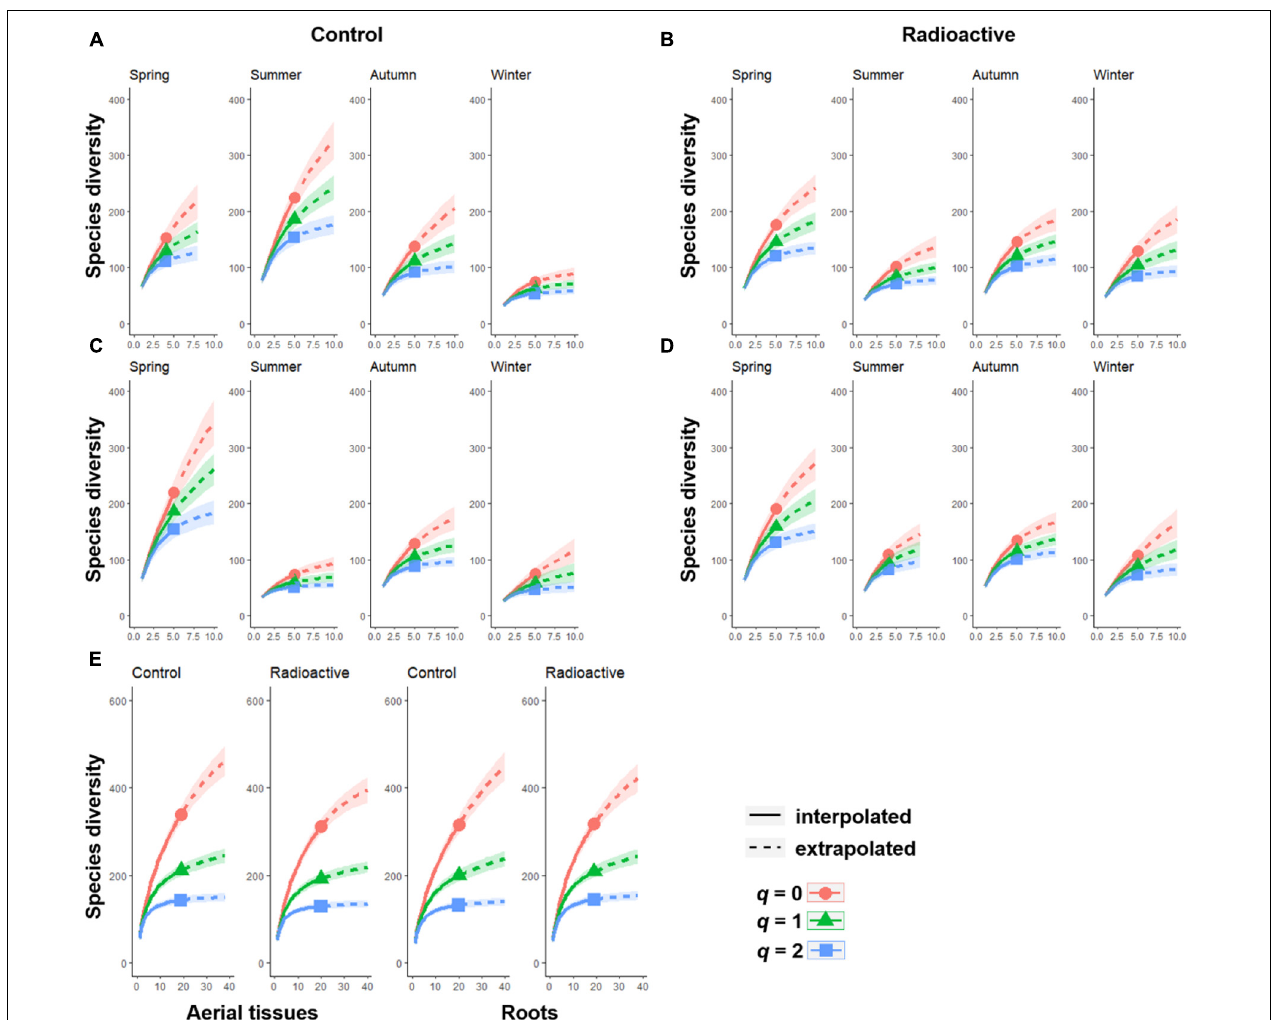
FIGURE 4 | The Hill numbers of order q indicate the diversity of endophytic fungi in each season at the control or radiation stressed sites. The sample size based on rarefactions and extrapolations of four seasons are shown for the fungal community in aerial tissues (A) or in roots (C) at the control site, and aerial tissues (B) or roots (D) at the radiation stressed site. The overall rarefactions and extrapolations of different tissues across four seasons are also illustrated (E)